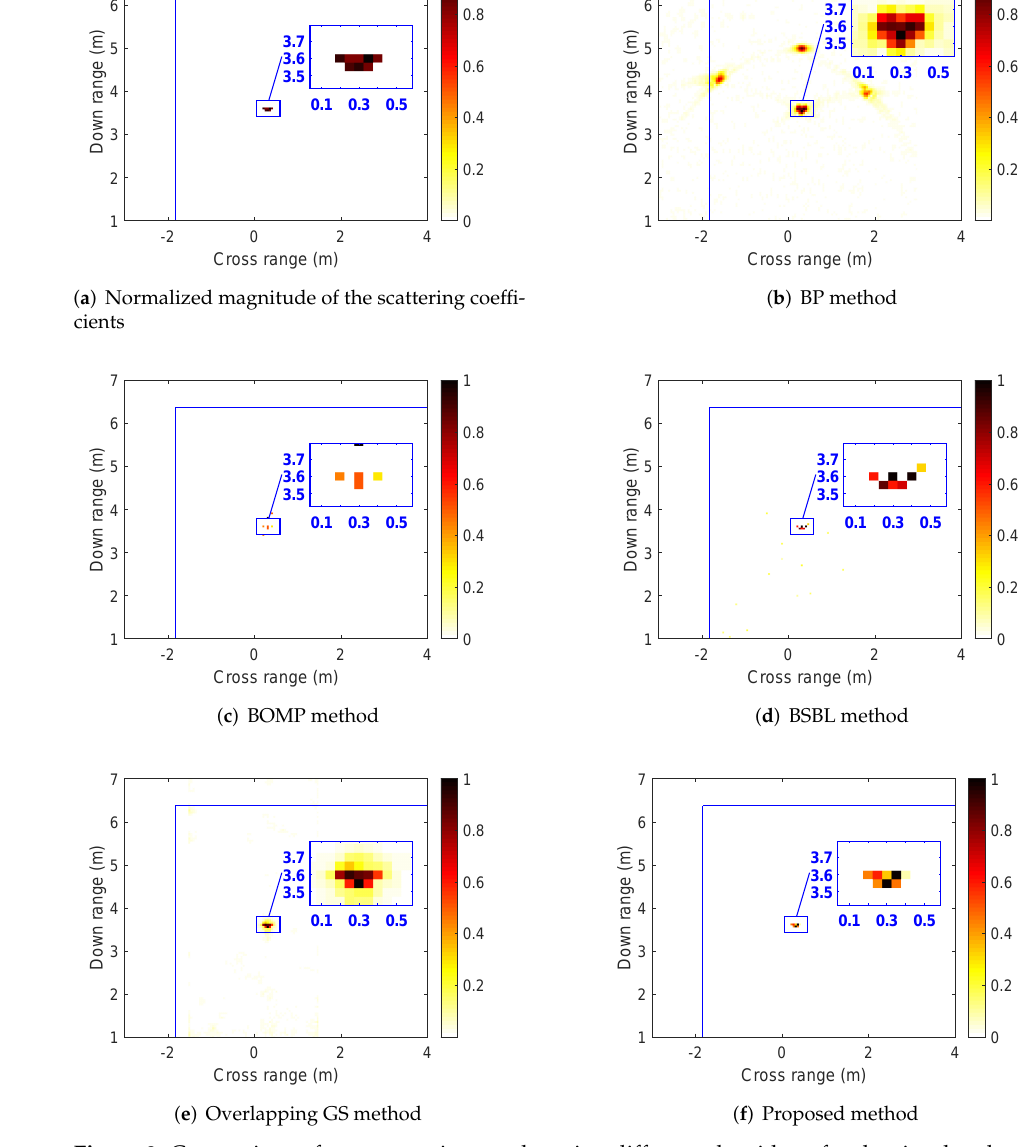
Figure 3. Comparison of reconstruction results using different algorithms for the simulated scene. ( a ) Ground truth. ( b ) BP-based reconstruction result using the full data. ( c ) Reconstruction result based on the BOMP method using one-fourth of measurements with known sparsity. ( d ) Reconstruction result based on the BSBL method using one-fourth of measurements. ( e ) Reconstruction result based on the Overlapping GS method using one-fourth of measurements. ( f ) Reconstruction result based on the proposed method using one-fourth of measurements. Table 3. Executive time